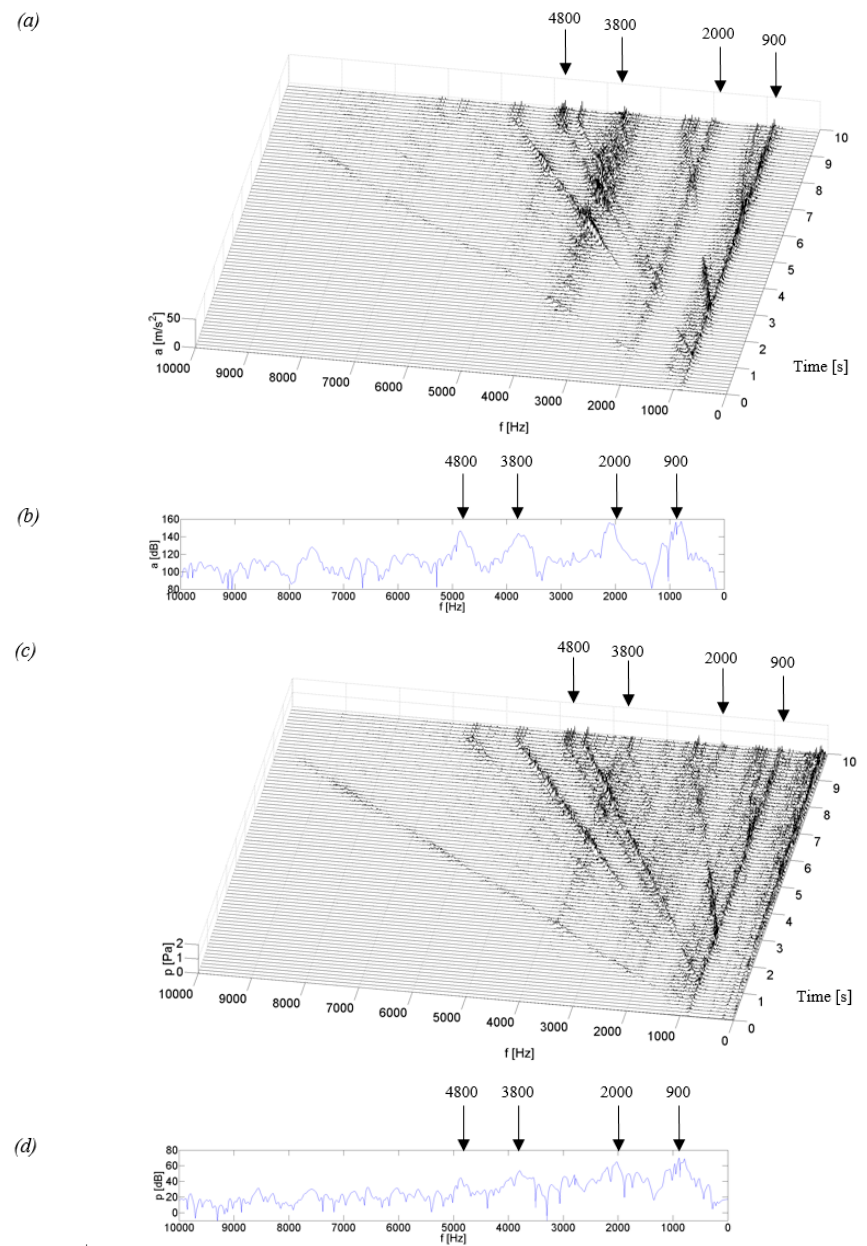
Figure 7. Test results for the K_3 housing: ( a ) time-frequency distributions of vibration acceleration (P_5), ( b ) vibration response (P_5), ( c ) time-frequency distributions of acoustic pressure ( H ), ( d ) acoustic response ( H ).